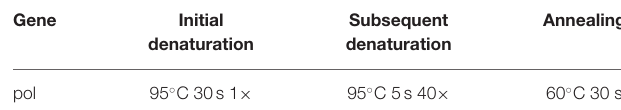
TABLE 2 | The protocol in qRT-PCR